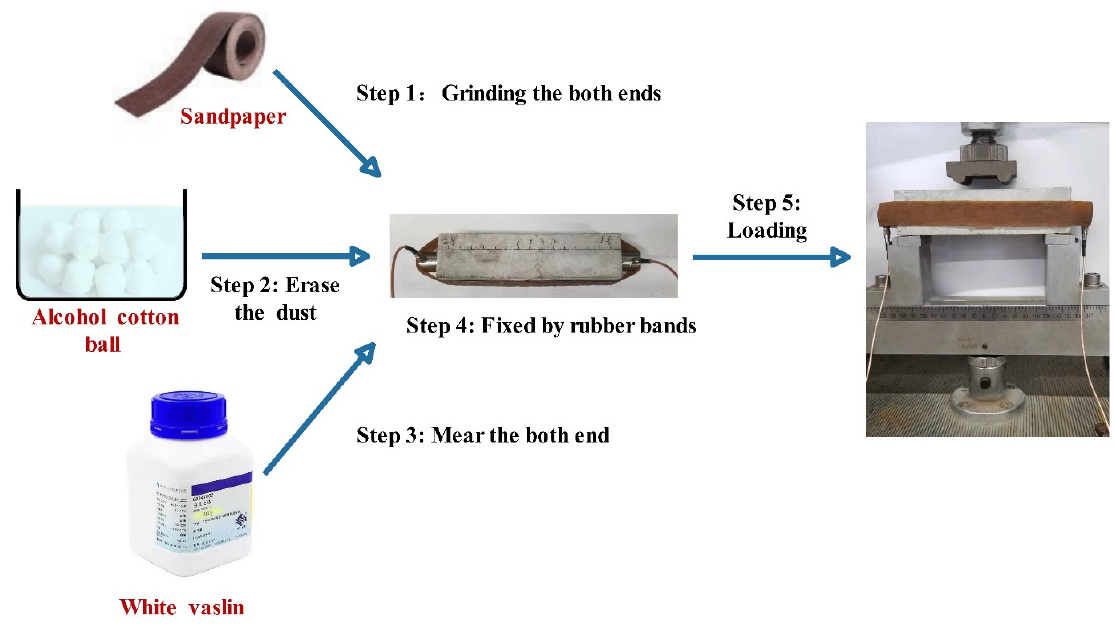
Figure 5. The flow chart of healing test.